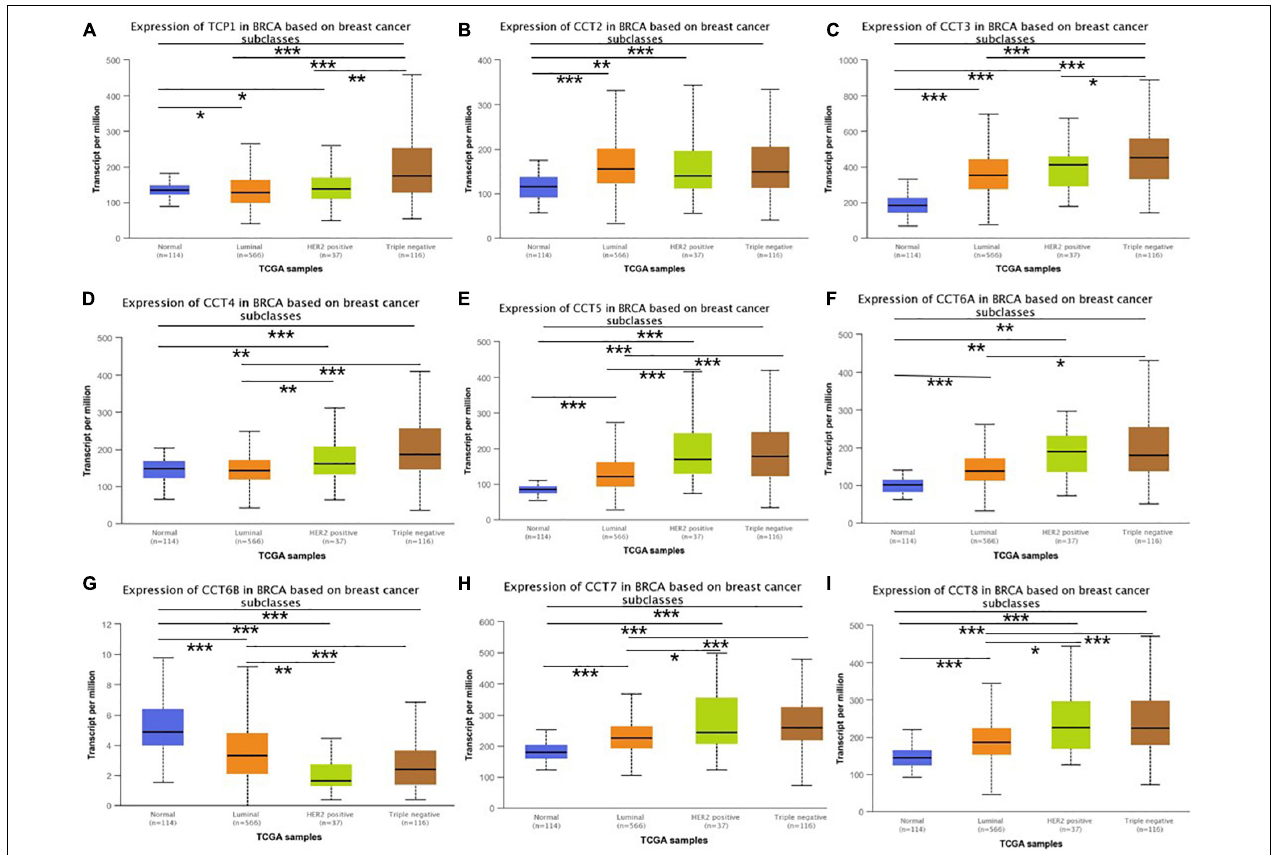
FIGURE 2 | Boxplot showed relative expression of eight subunits of the chaperonin TRiC in BCa patients with different molecular subtypes and in normal individuals based on UACLAN database. (A) TCP1, (B) CCT2, (C) CCT3, (D) CCT4, (E) CCT5, (F) CCT6A, (G) CCT6B, (H) CCT7, and (I) CCT8. * p < 0.05; ** p < 0.01; *** p <